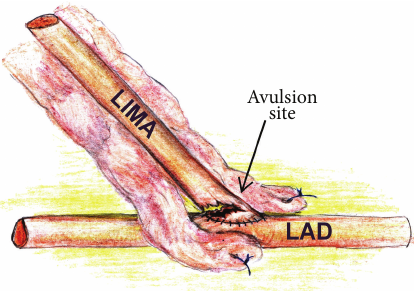
Figure 1: Finding during reexploration. LIMA: left internal mam- mary artery graft; LAD: left anterior descending artery.